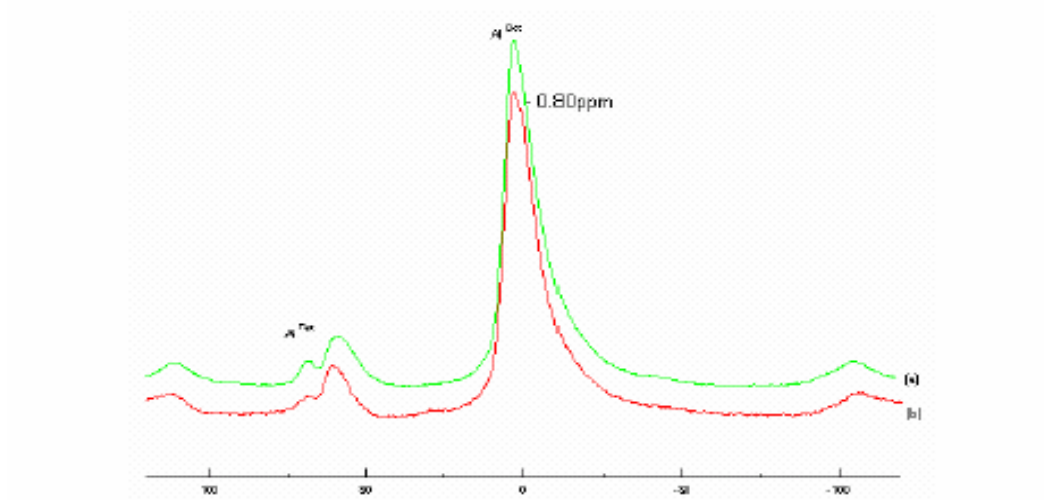
Figure 3. 27 Al MAS NMR spectra of (a) “Raw-Maghnite” and (b) “H-Maghnite